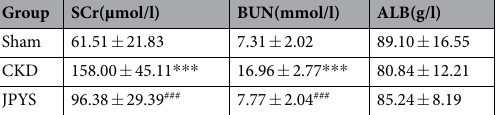
Table 1. Renal function data (means ± SD). *** P < 0.001 between Sham and CKD groups; ### P < 0.001 between CKD and JPYS